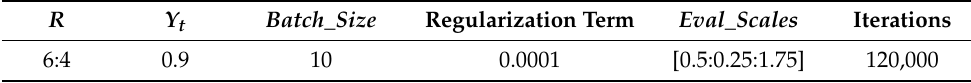
Table 3. Values of various parameters in the DeepLab V3+